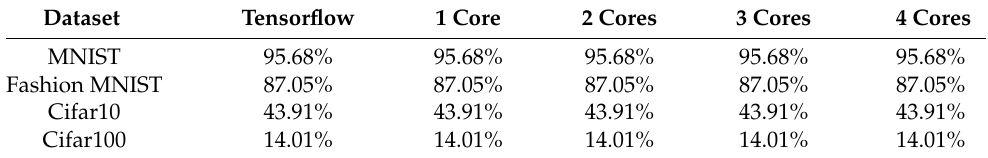
Table 3. Accuracy for each